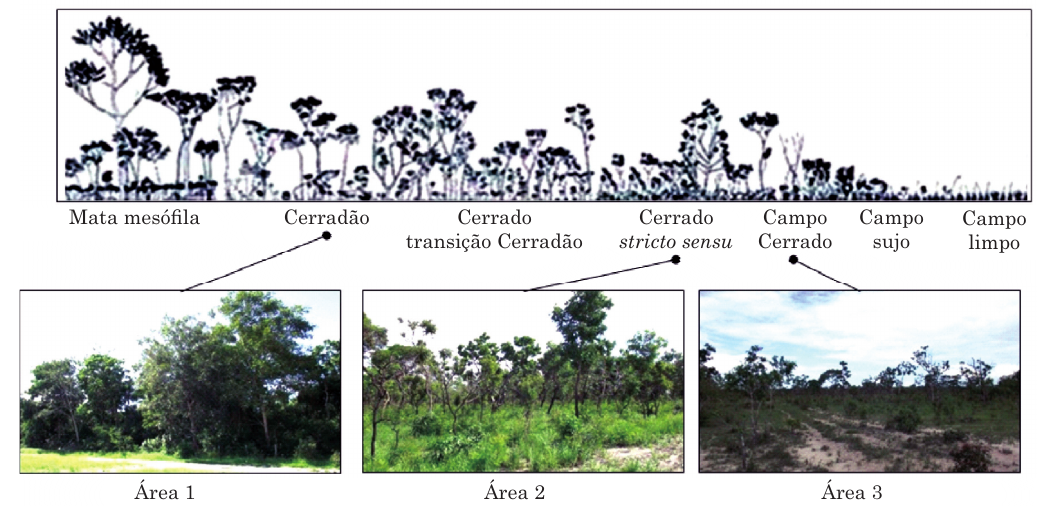
Figura 2. Áreas com suas respectivas vegetações. Fonte: Adaptada de Costa